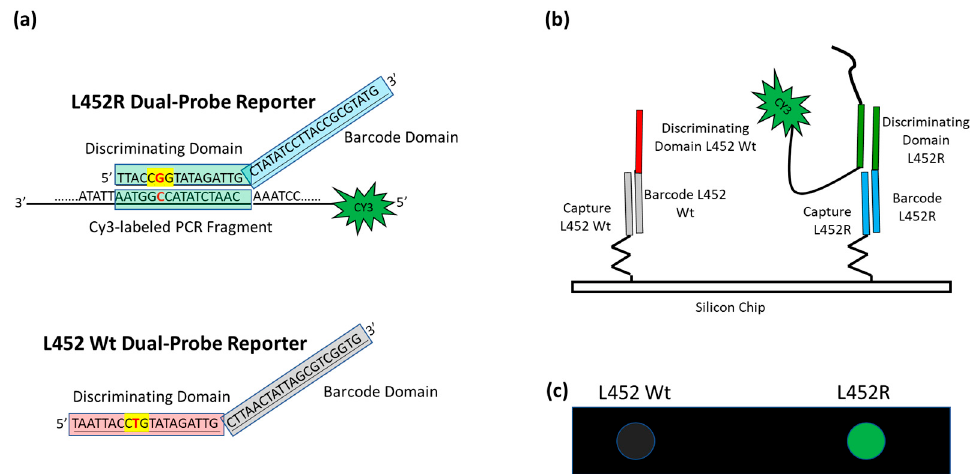
Figure 2. Schematic of the assay. ( a ) In the case of L452R mutation (the nucleotide triplet encompassing the point mutation is highlighted in yellow with the mutation in red), the Discriminating Domain of the L452R Dual-domain reporter hybridizes in solution with the Cy3 labeled single strand PCR, whereas the L452 Wt Dual-domain reporter does not. ( b ) The different Barcode Domains in the 3 ′ portion of the Dual-domain reporters (the different colors represent difference in the sequences) direct the labeled PCR to different positions on the array by surface hybridization with the corresponding capture probes. ( c ) The incorporation of Cy3-Reverse primers into the PCR amplicons allows the exact mutation present in the protein S gene to be detected by fluorescence scanning. The image shows the highlighting of the spot corresponding to mutation L452R, whereas the spot corresponding to L452 Wt remains dark.